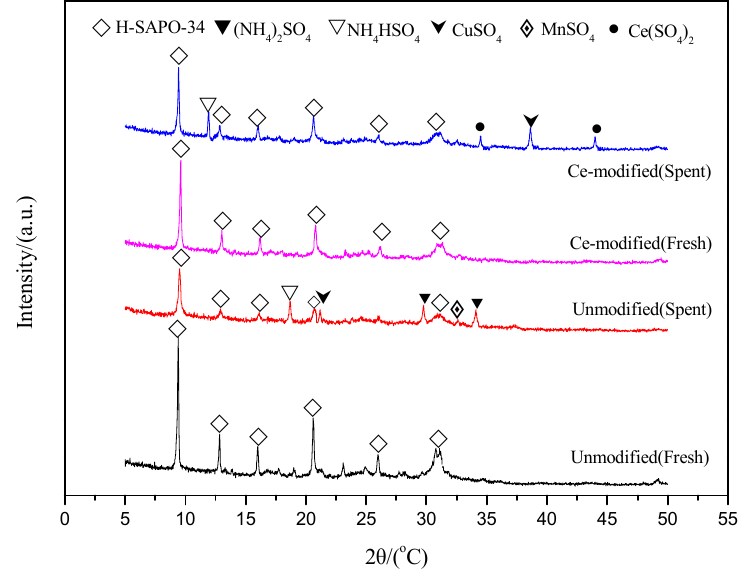
Figure 6. XRD pattern of 2% Ce-modified catalyst after SO 2 poisoning.